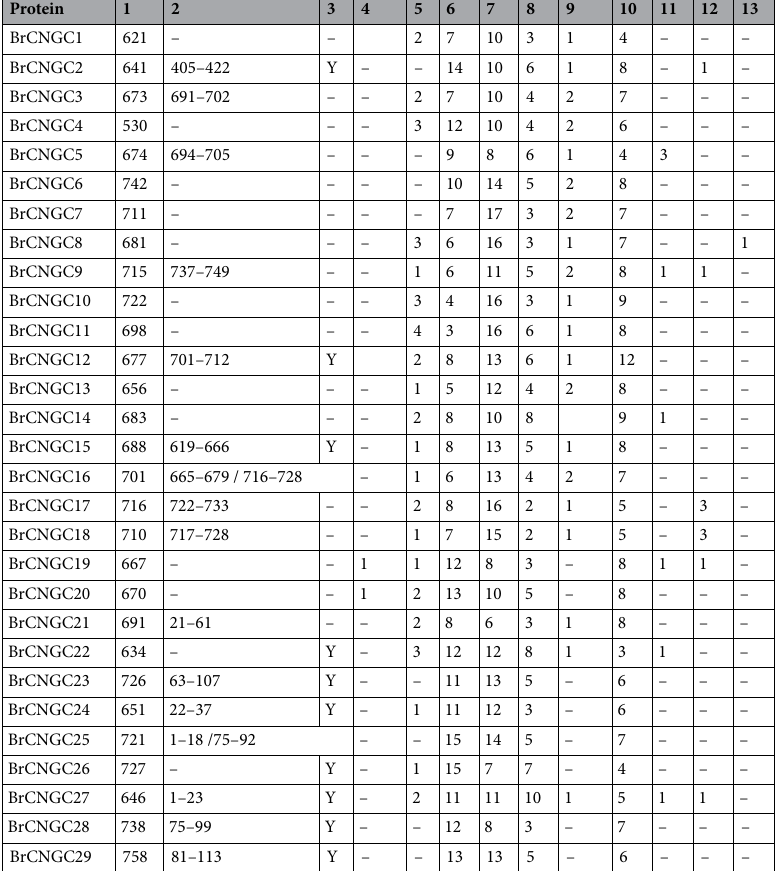
Table 4. Post-translation modification and phosphorylation sites within the 29 BrCNGC encoded protein sequences. 1 = non-potential GPI modification site, 2 = PEST motifs, 3 = cTP-containing sequence, 4 = GLU-RICH, 5 = cAMP- and cGMP-dependent protein kinase phosphorylation sit, 6 = Casein kinase II phosphorylation site, 7 = Protein kinase C phosphorylation site, 8 = N-glycosylation site, 9 = Tyrosine phosphorylation site, 10 = Myristoylation, 11 = Amidation, 12 = Leucine zipper, 13 = ATP/GTP-binding site motif A